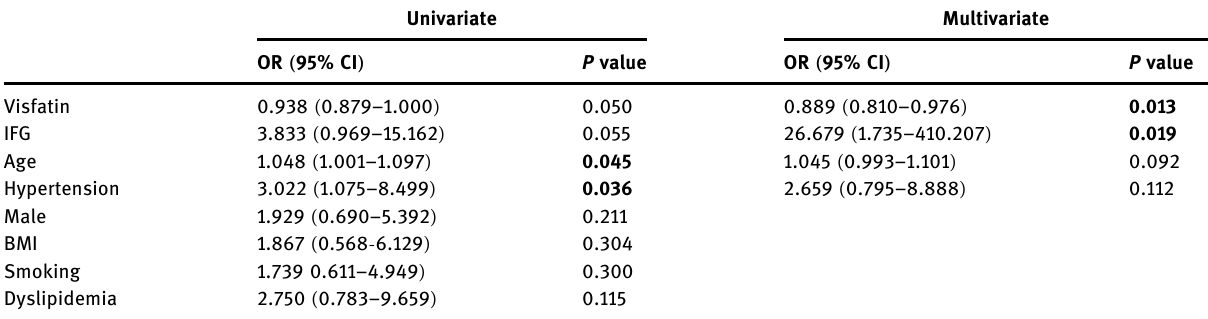
Table 2: Univariate and multivariate logistic regression analyses for independent predictors of the presence of CAD Univariate